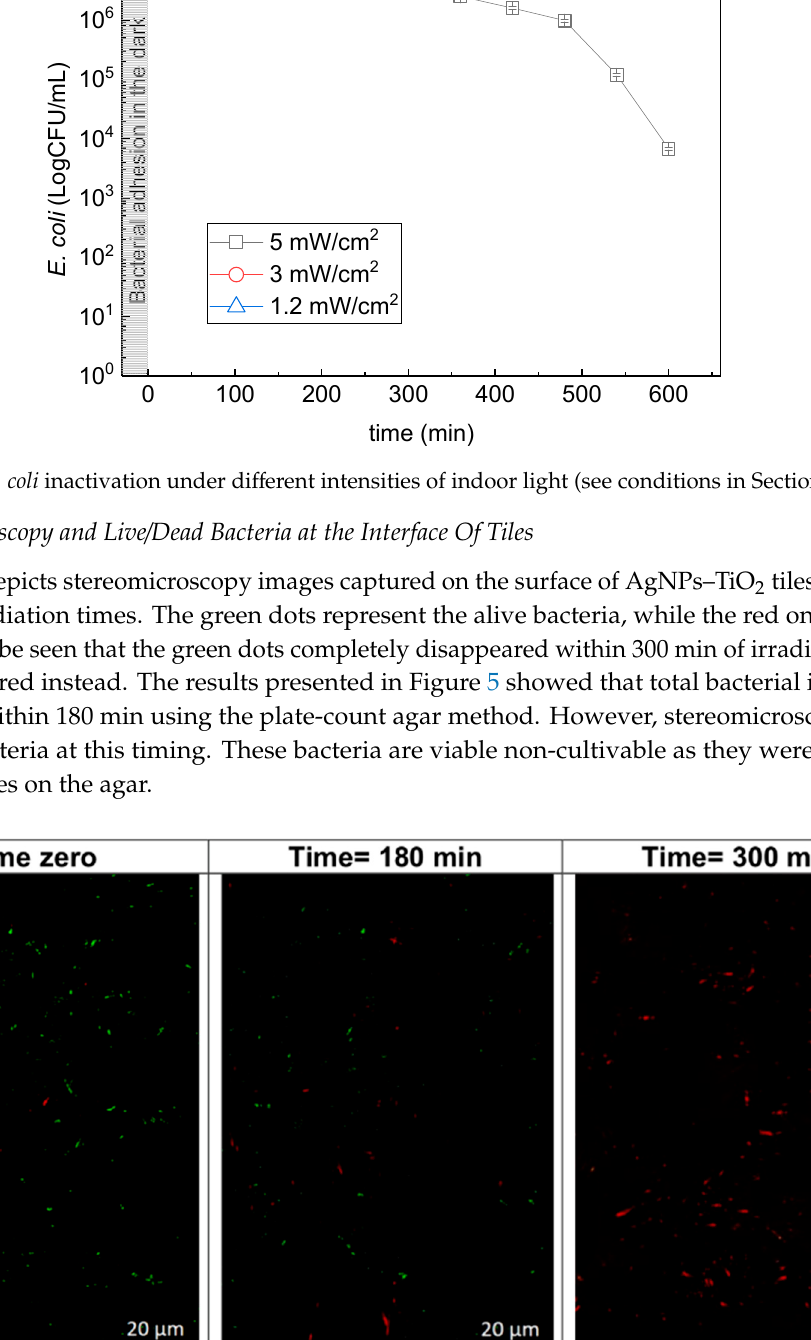
Figure 6. E. coli inactivation on AgNPs–TiO 2 ceramic tiles under low intensity solar simulated light (50 mW/cm 2 ) at different E. coli initial concentrations.